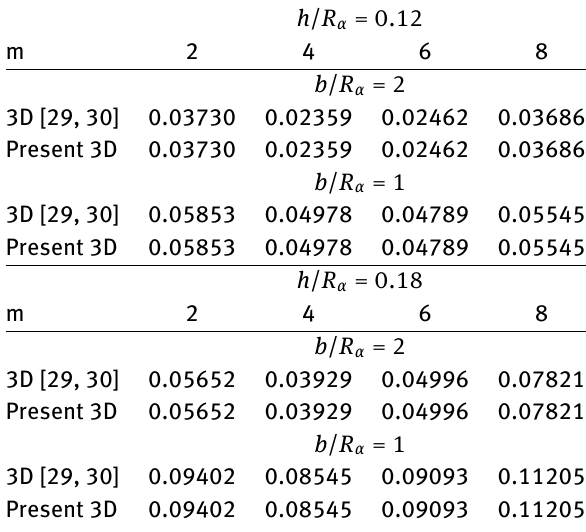
Table 2: Second assessment for the 3D exact solution, simply sup- ported cylinder made of aluminium alloy with different thickness ratios h / R α . First circular frequency ¯ ω = ω h m